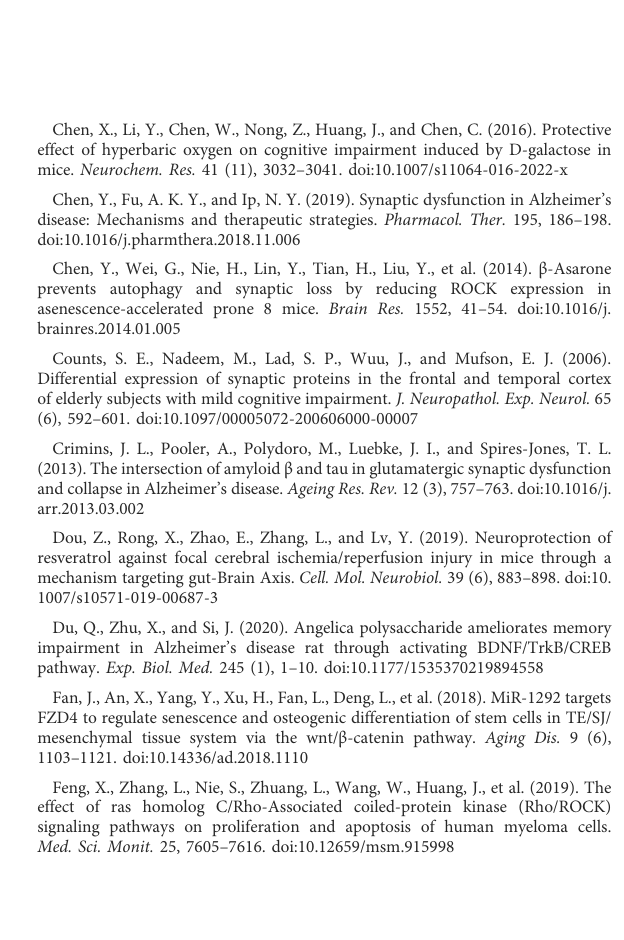
SUPPLEMENTARY FIGURE S1 The trajectory of the mouse to fi nd the